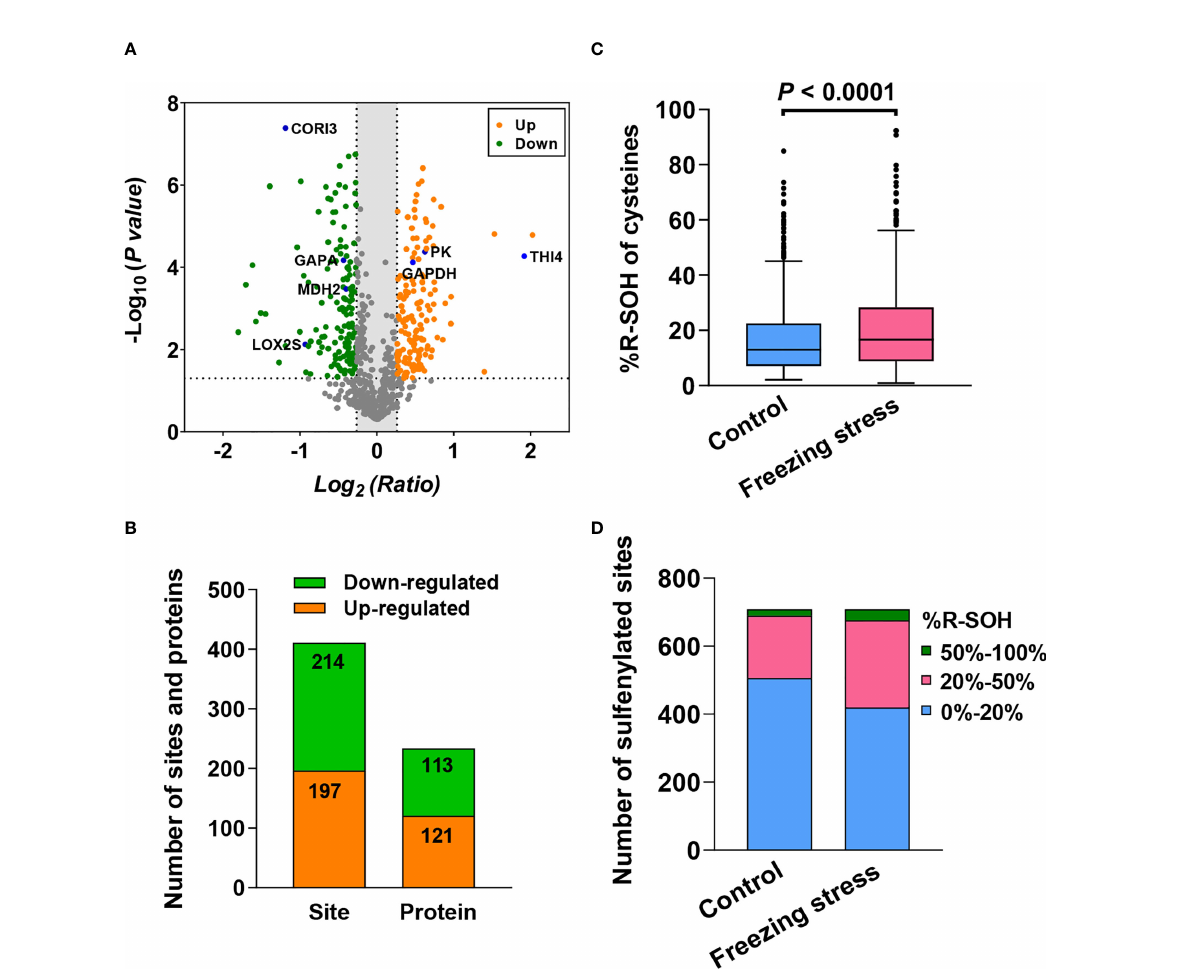
FIGURE 3 Freezing stress after cold acclimation caused the change in protein abundance and sulfenylation level (%R-SOH) of sites and proteins in B napus. (A) Volcano plot of the 857 sites quanti fi ed in at least 2 out of 3 replicates under both control and stressed conditions. The statistical signi fi cance -Log 10 ( P value) on the y-axis and the expression level change Log 2 (Ratio) on the x-axis. Ratio means the ratio of cysteine level under stress to that under control condition. Red dots represent the sites with up-regulated expression level (ratio > 1.2) and green dots represent the sites with down-regulated expression level (ratio < 0.83). The dotted line on the y-axis shows P value of 0.05, and the dotted lines on the x-axis show ratio of 1.2 and 0.83. Some known proteins in A thaliana are marked in blue in the volcano plot. (B) The number of sites and proteins with signi fi cant abundance changes under stress ( P < 0.05). (C) Sulfenylation level of the 709 sites quanti fi ed in at least 2 out of 3 replicates under control and stressed conditions. %R-SOH means the proportion of modi fi ed state abundance to the total abundance of a single site, which was used to indicate the sulfenylation level. (D) %R-SOH distribution of the 709 sites under control and stressed